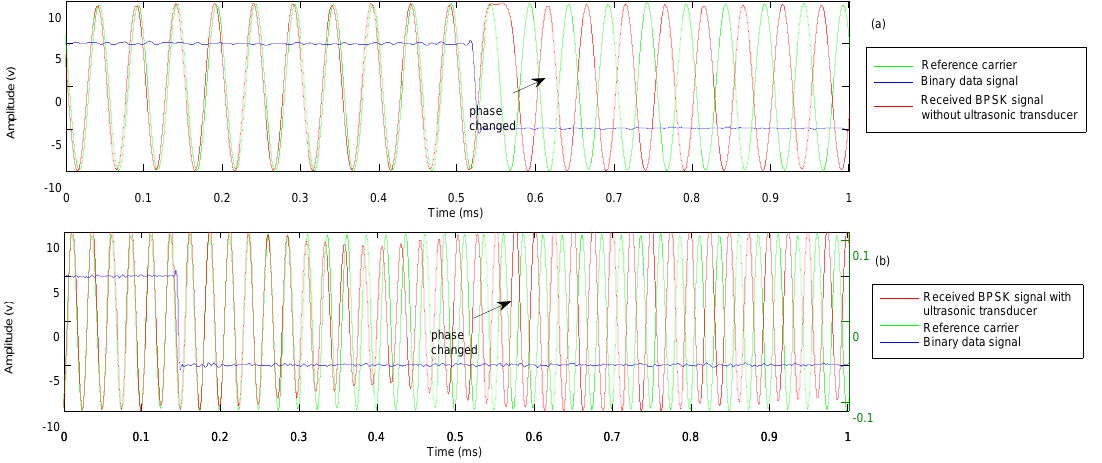
Figure 7. ( a ) Transition of transmittedbinary PSK (BPSK) signal; ( b ) Transition of received BPSK signal.